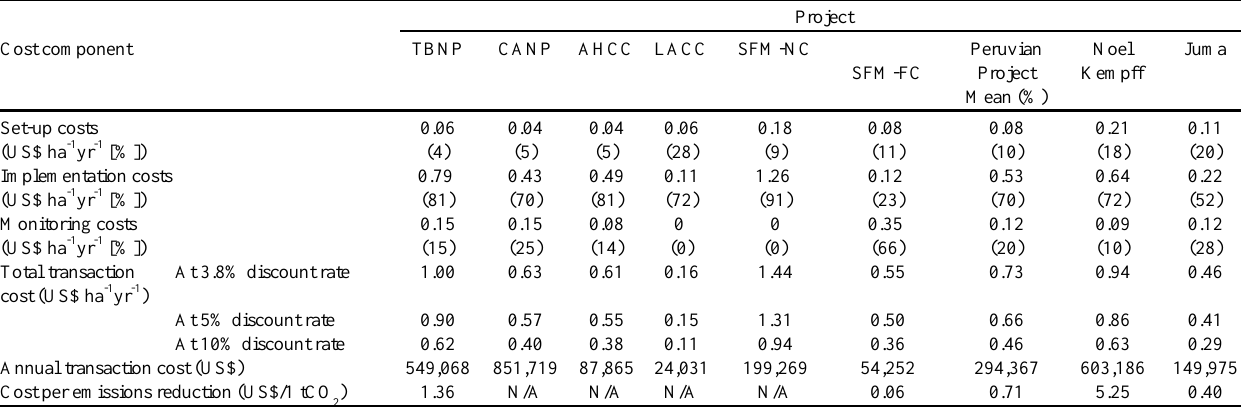
Table 3 . Summary of estimated costs for the six Peruvian projects and the actual costs of two established projects in Bolivia and Brazil, including: set up, implementation, and monitoring costs annually per hectare and as a percentage of the total; projects’ total annual transaction cost per hectare at 3.8%, 5%, and 10% discount rate; total annual transaction cost in US$; and estimated cost of reducing 1 tCO emissions for two projects in Peru compared with the two established projects in Bolivia and Brazil. 2 Note that all values are reported as average net present value discounted at 3.8% (unless otherwise stated). The data for the Bolivian and Brazilian projects was obtained from Brown et al. 2000, Asquith et al. 2002, FAS 2008, and Brown 2005. Project acronyms are defined in Figure